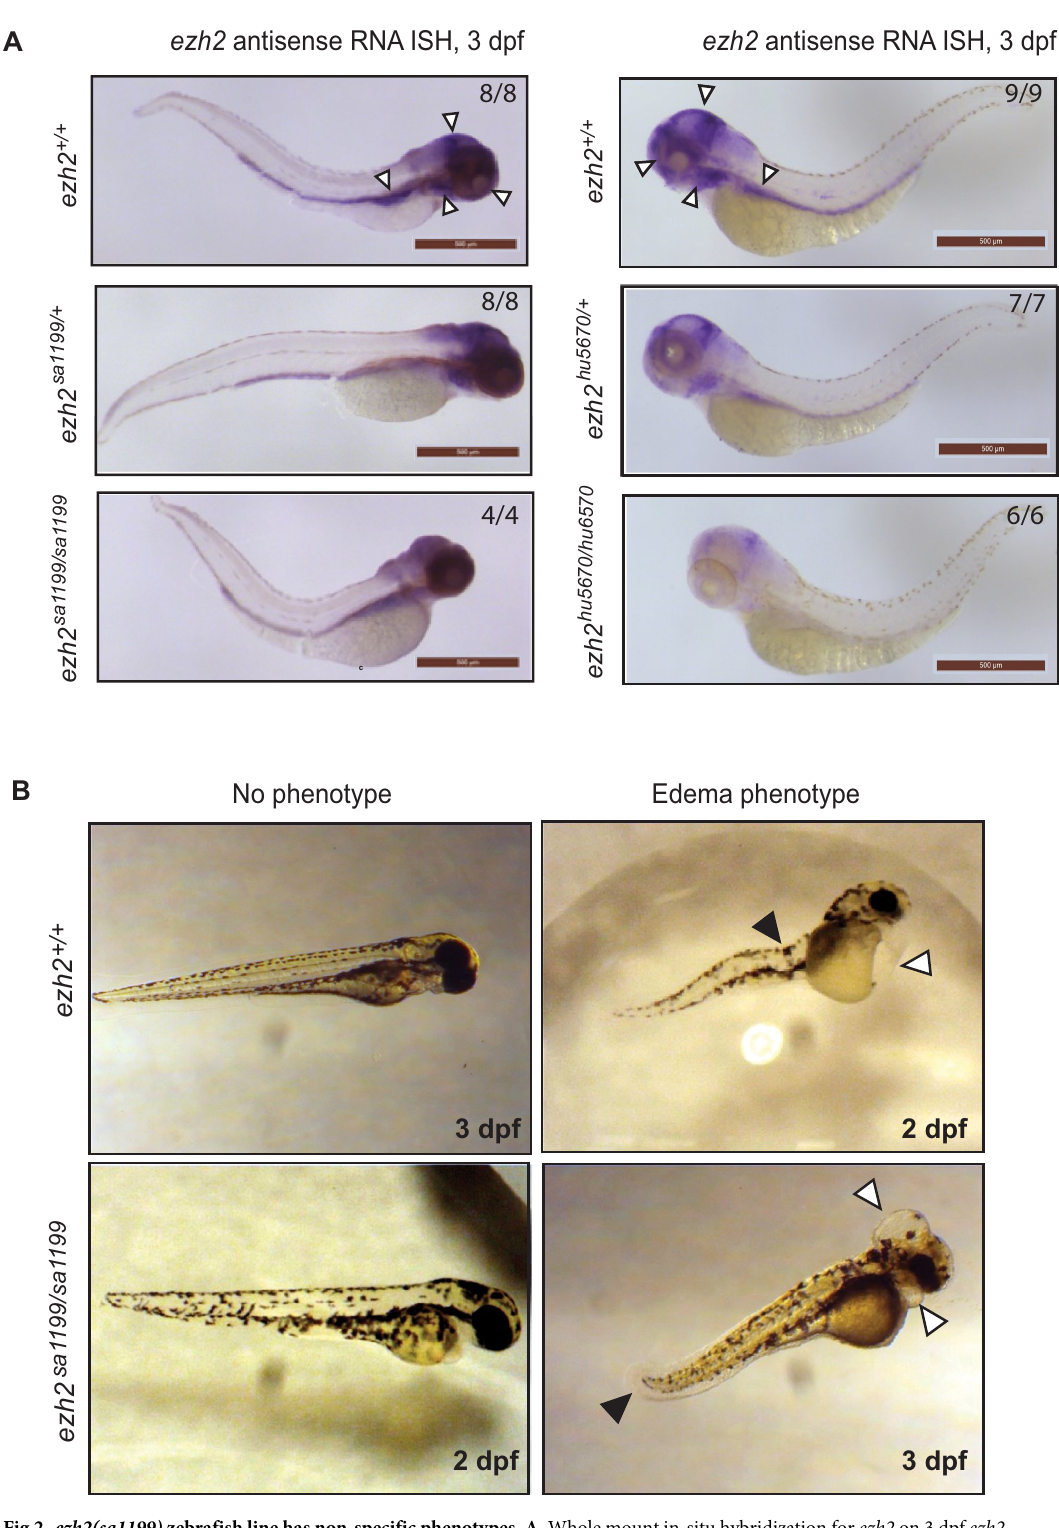
Fig 2. ezh2(sa1199) zebrafish line has non-specific phenotypes. A. Whole mount in-situ hybridization for ezh2 on 3 dpf ezh2 (sa1199) (left panel) and ezh2(hu5670) (right panel) embryos. Left panel . Wild type siblings (top) show ezh2 expression in the brain, eyes, branchial arches, and the gut (white arrowheads). Heterozygotes (middle) and ezh2(sa1199) mutants (bottom) show the